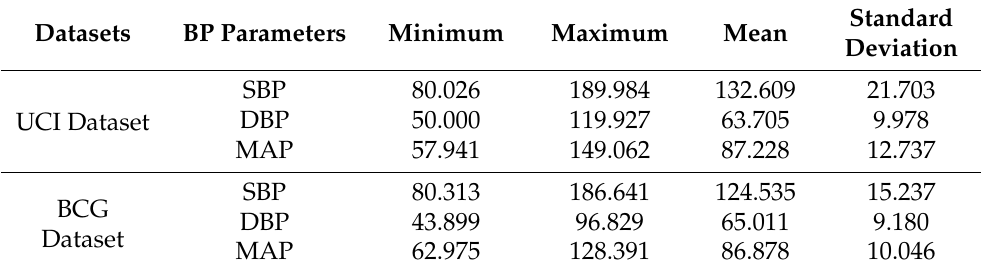
Table 1. Overview of the datasets (after